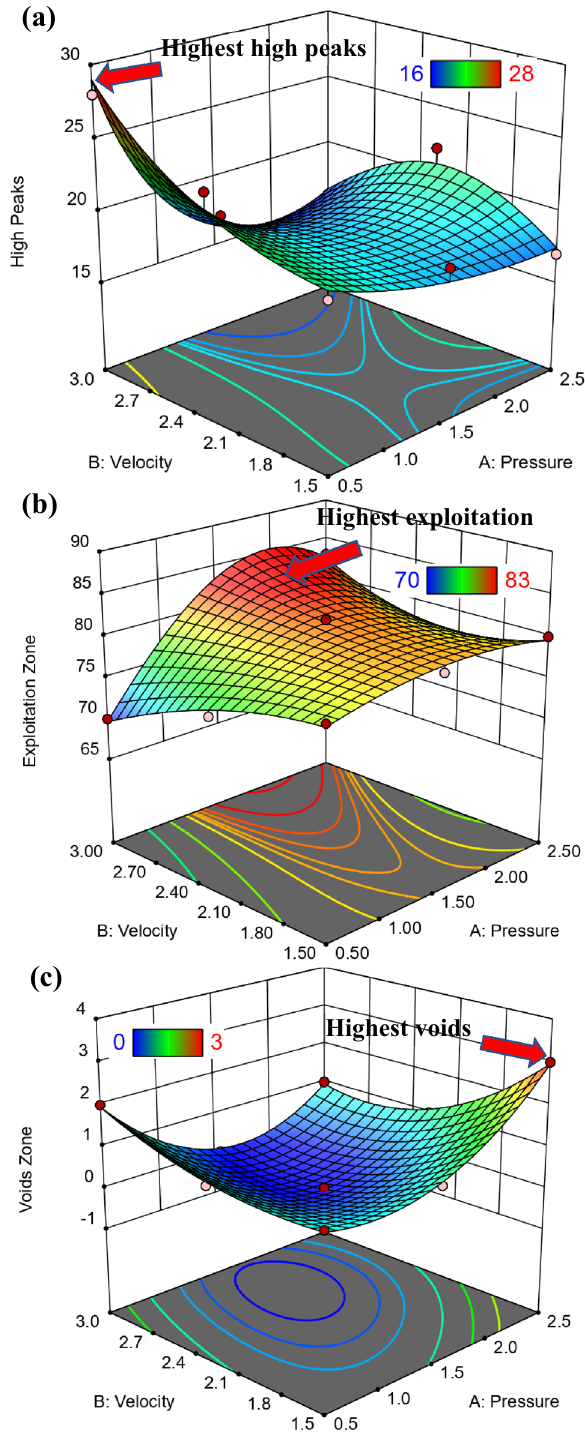
Figure 12. 3D Surface plot of ( a ) high peaks, ( b ) exploitation, and ( c ) voids zones of